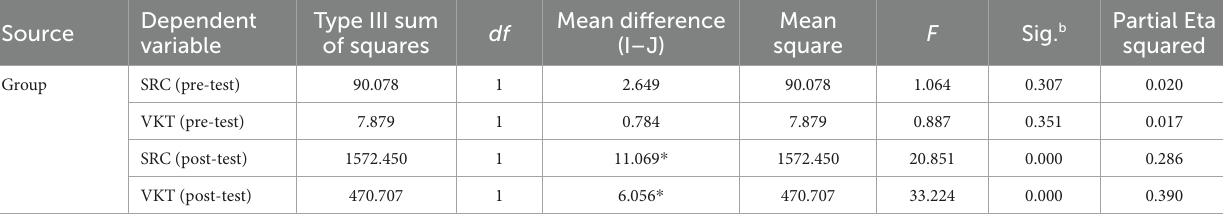
TABLE 3 Tests of between-subjects effects.